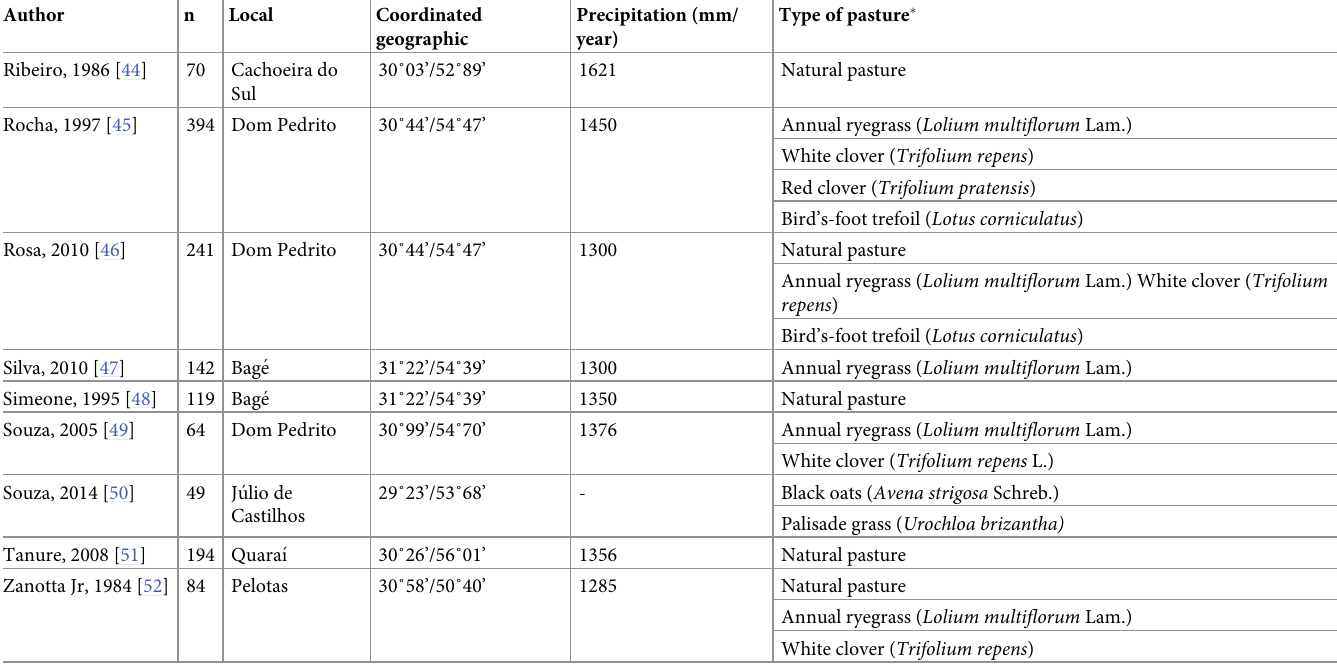
First, pregnancy rate (PR) was analyzed using glmer with a binomial distribution and a logit link, as a function of known proximate factors such as body weight and category. Breed was included to account for inherent differences in breeds that could modulate the effects of body weight, for example, due to differences in mature body or frame size. Model selection pro- ceeded by simplification of a full model until it had only those effects that were significant or part of significant interactions. Significance of terms was assessed by type II Wald tests using the Anova() function of the car package [27]. The initial full model, expressed as an R formula for the generalized linear mixed-effects model (glmer) function of the lme4 package [57] was